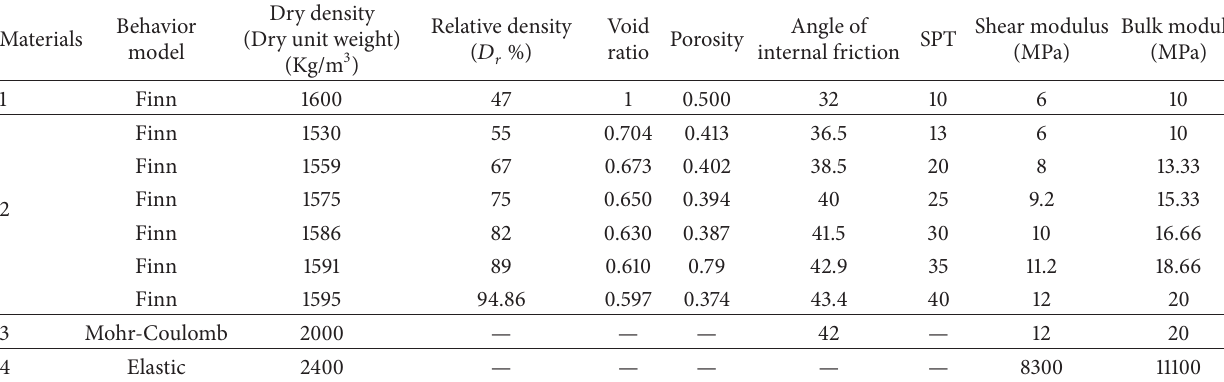
Table 1: Features of the materials used in the analytical models of the gravity quay